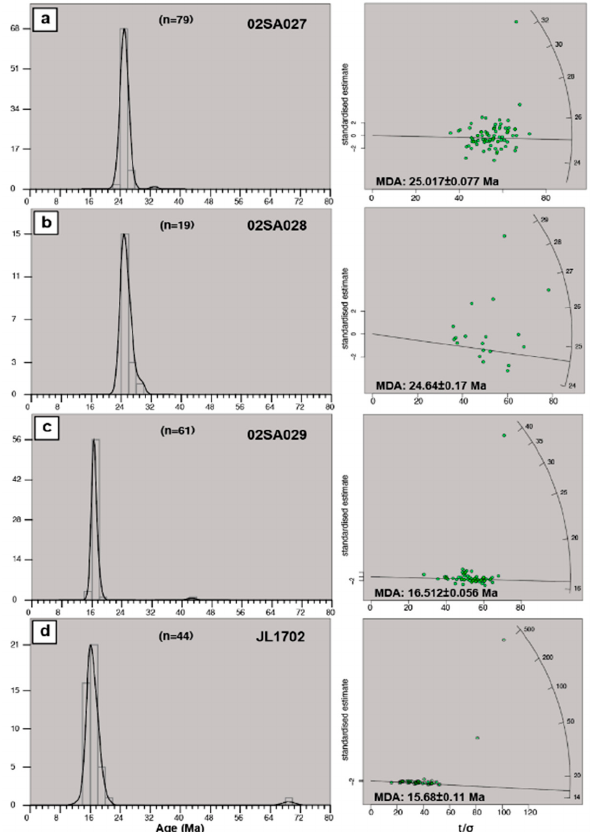
Figure 12. Frequency and probability density plots of detrital zircon U-Pb ages (left) and maximum depositional ages (MDA, right) from samples of the Silante Formation ( a ) sample 02SA027; ( b ) 02SA028; ( c ) 02SA029; ( d ) JL1702. The t/ ơ ratio on X-axis indicates the precision.